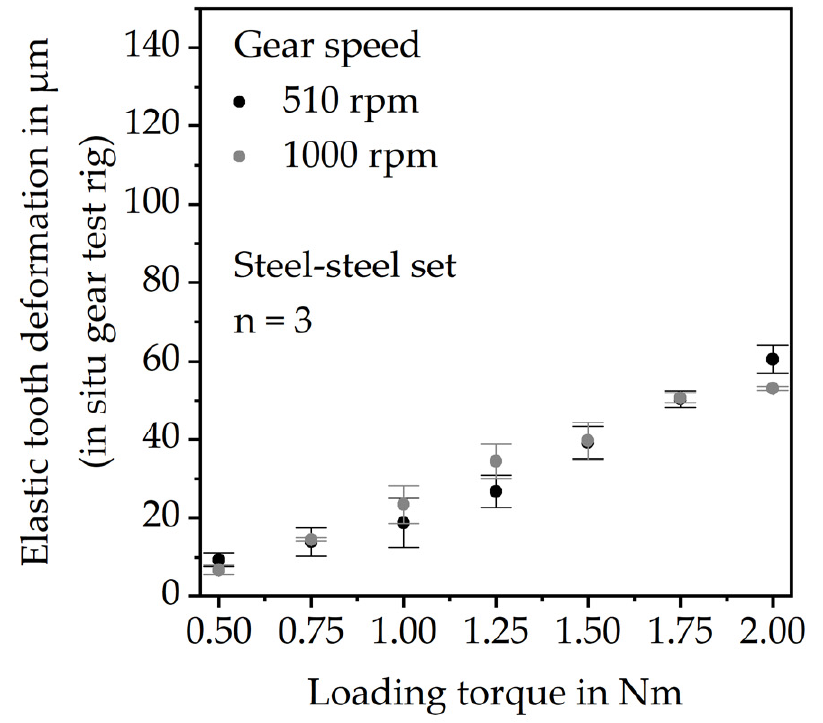
Figure 9. Measurement offset of the in situ gear test rig.